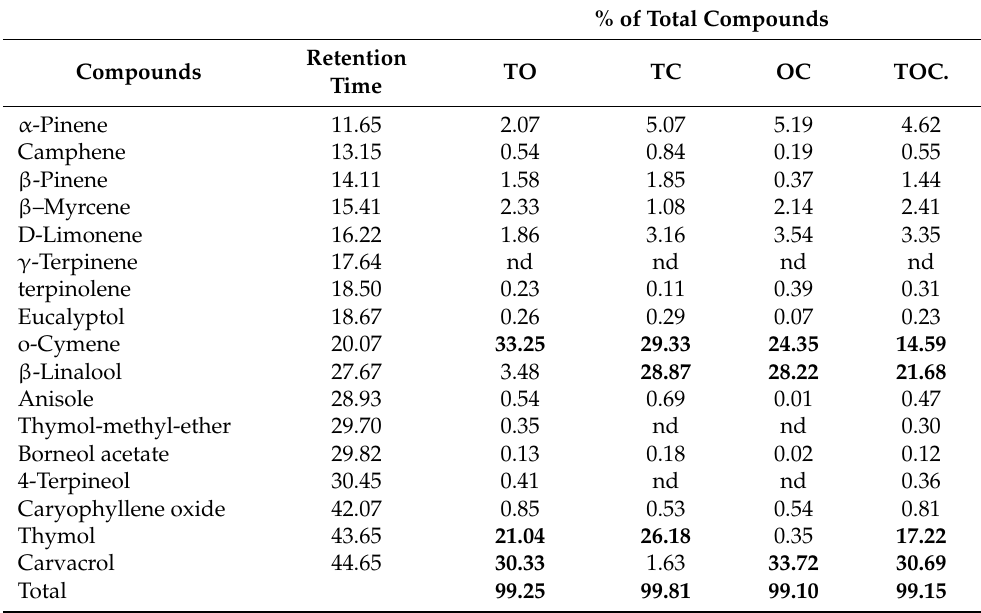
Table 2. Chemical composition of binary and tertiary mixtures of EOs *.